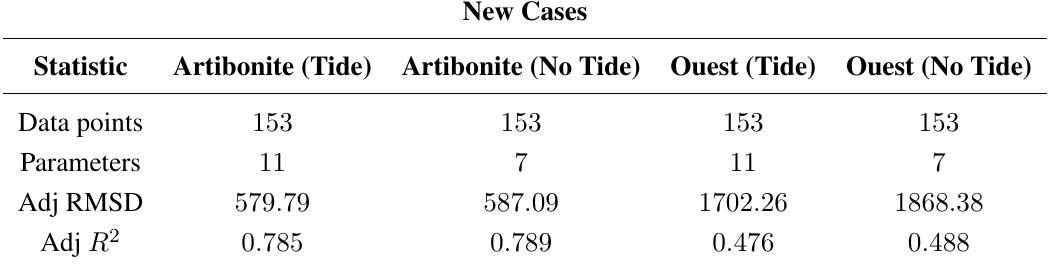
Table 4. Model predictions versus data statistics for new cases: root mean squared deviations (RMSD), coefficient of determination ( R 2 ) . Degrees of freedom for the statistics are adjusted by the number of parameters fit in the calibration